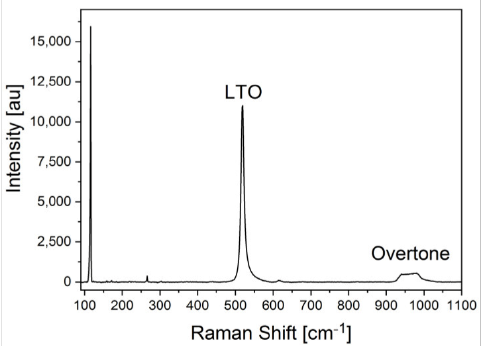
Figure 5. Raman spectrum of the silicon unmounted chip, measured using 514.5 nm radiation from an Ar